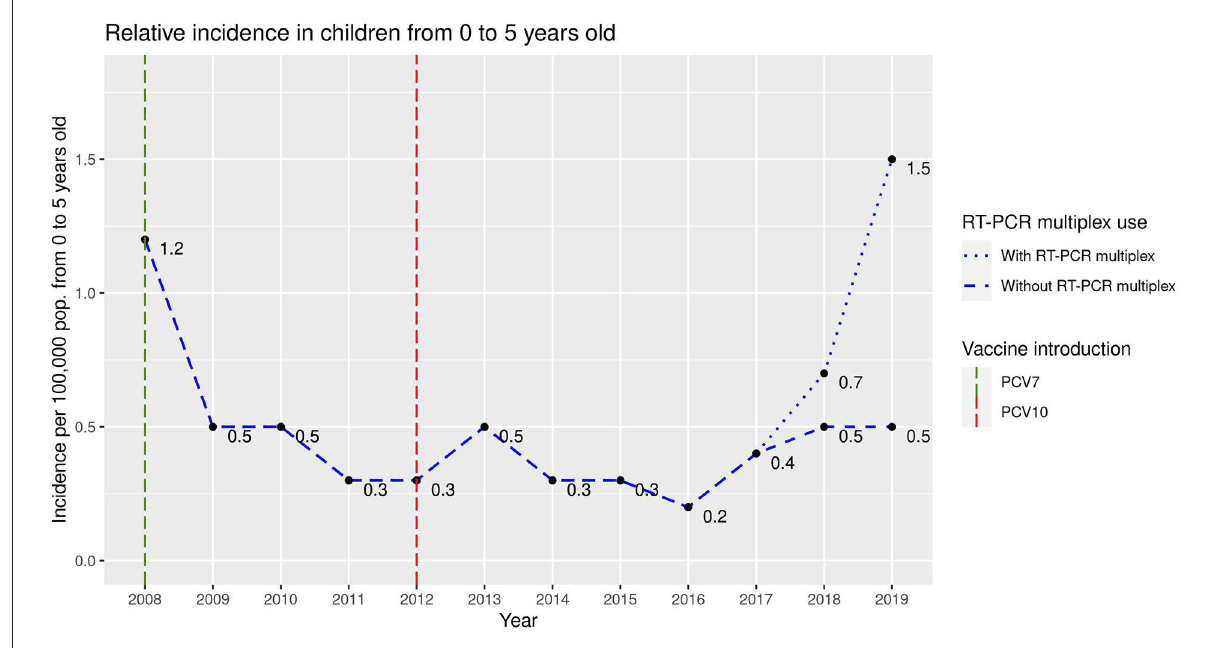
FIGURE1 Relative incidence of acute bacterial meningitis in children between 0 and 5 years of age in